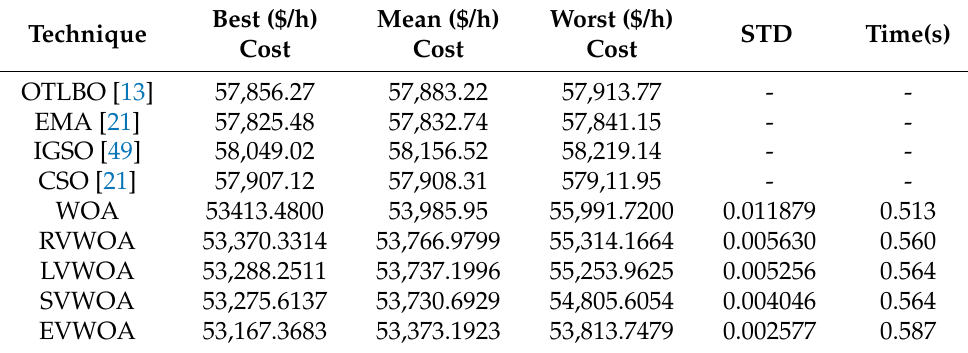
Table 11. Optimal schedule for the best cost obtained for Case study 4.